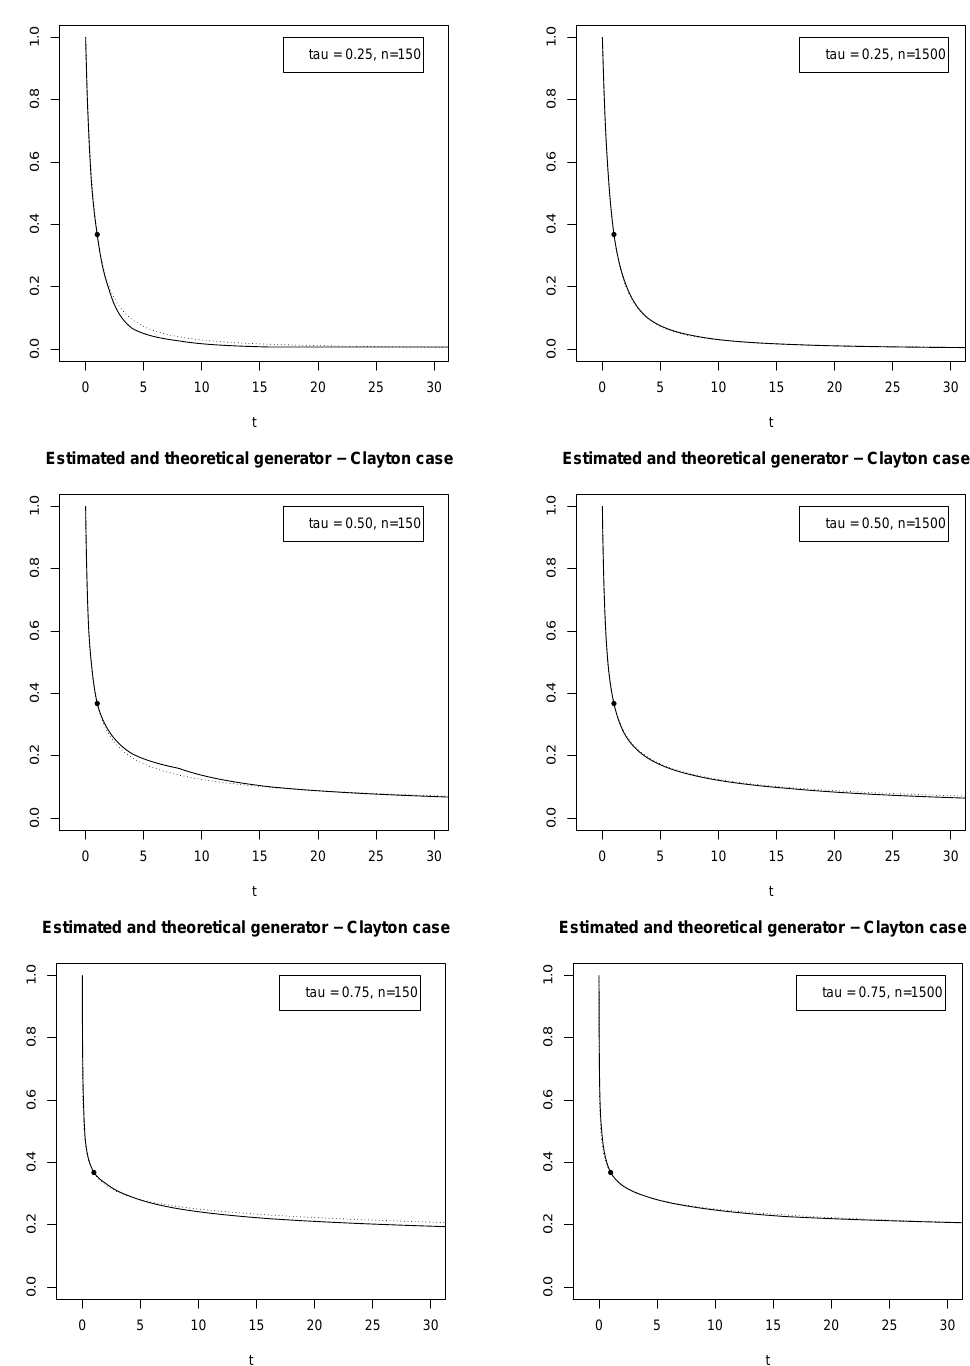
Figure 6. Estimated versus theoretical Clayton-generator with Kendall’s τ and n = 1500 (right column). Estimated b φ ( t ) = b δ ρ i.e., ¯ φ ( t ) = (cid:0) 1 + (e θ − 1) t (cid:1) − 1 /θ , is drawn using a dashed line. We force the generators to pass through the point ( t